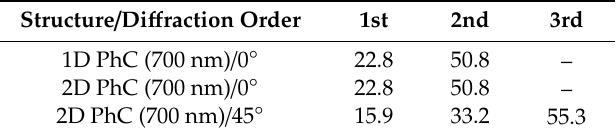
Figure 6. ( a ) Comparison of radiation pattern diagram of LED with 1D PhC and ( b ) 2D PhC measured at two different directions.